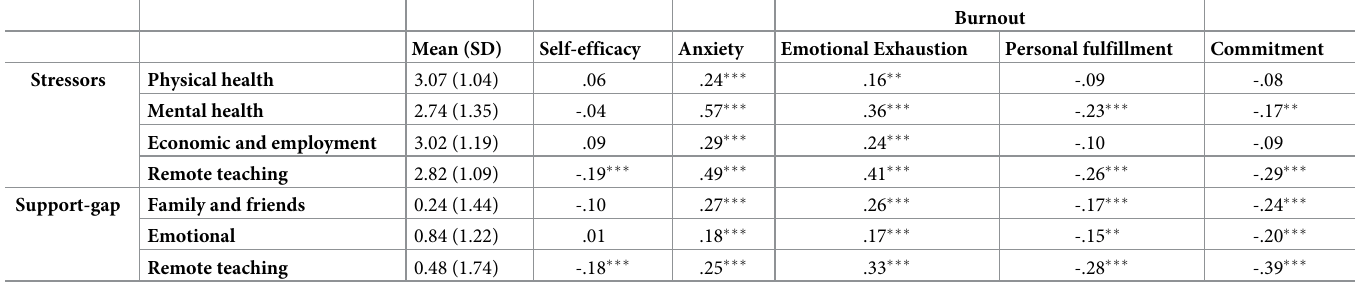
Table 3. Descriptive statistics and Pearson correlational analyses a of the relationships between different types of stressors and sources of support-gap resulting from the COVID-19 pandemic and other